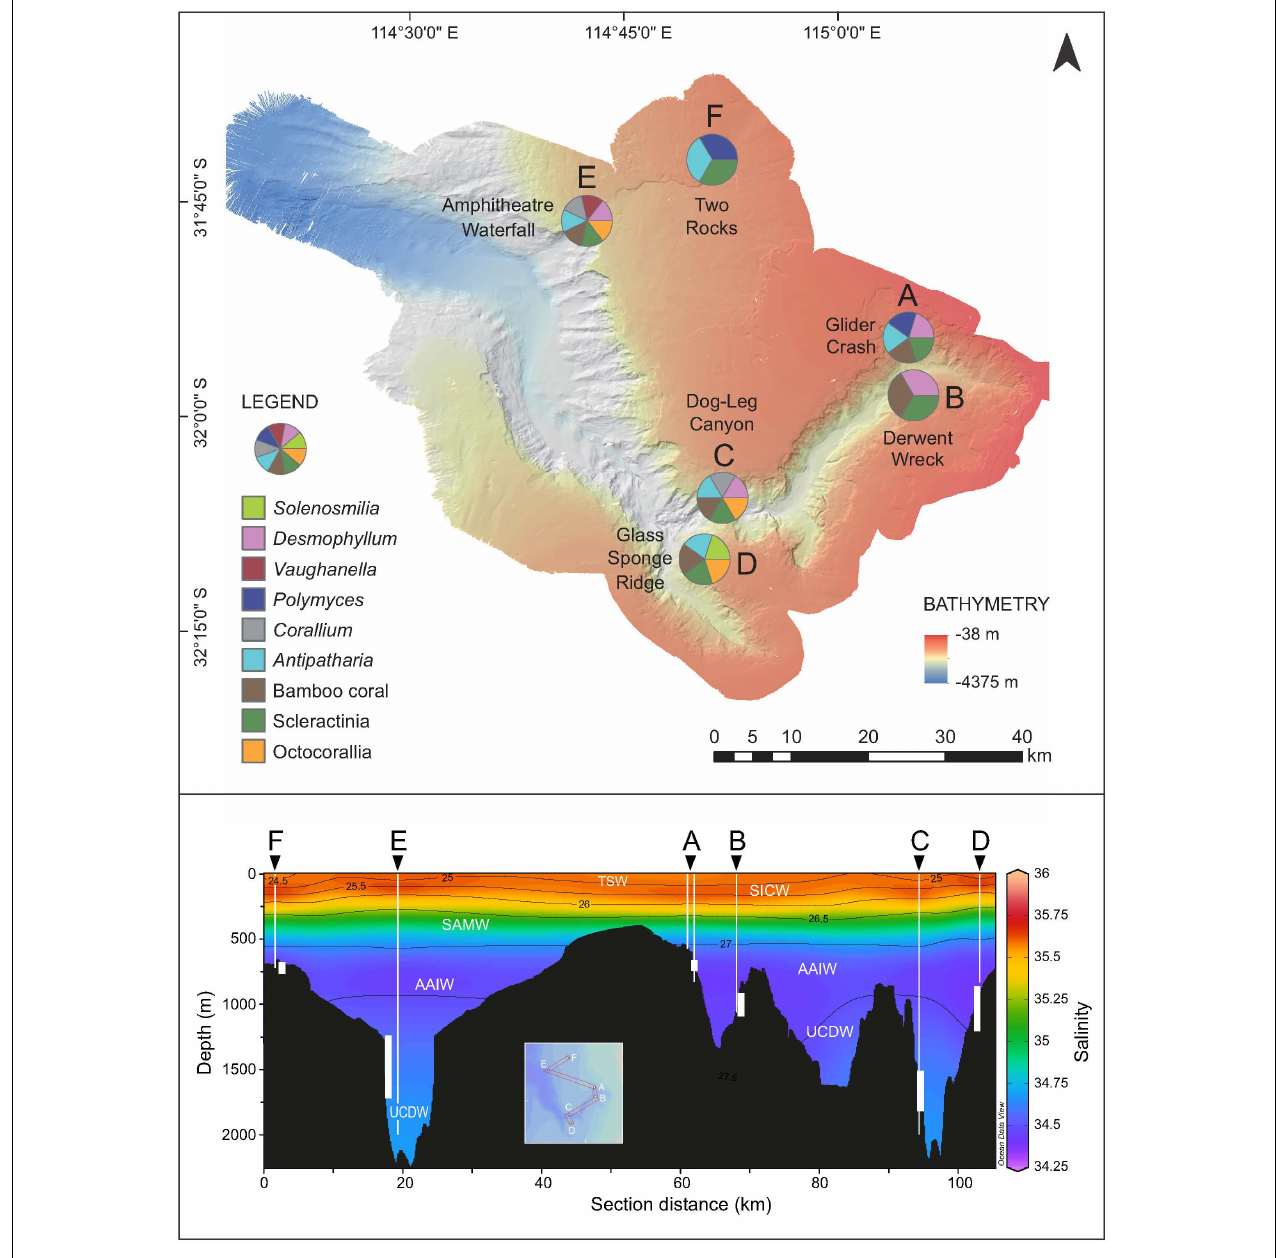
FIGURE 10 | Key coral taxa observed alive during the ROV dives and the relationship of water masses to the dive survey depths. Salinity-depth profile of the canyon waters (bottom) show neutral density contours (kg/m 3 ), water masses, depth range of each dive (white vertical bars), and CTD casts (white vertical lines). Inset shows path of section to generate seawater profile which is interpolated between sites. TSW, Tropical Surface Water; SICW, Subtropical Indian Central Water; SAMW, Subantarctic Mode Water; AAIW, Antarctic Intermediate Water; UCDW, Upper Circumpolar Deep Water. Sectors of pie charts are not proportional to abundance. Seawater profile generated using Ocean Data